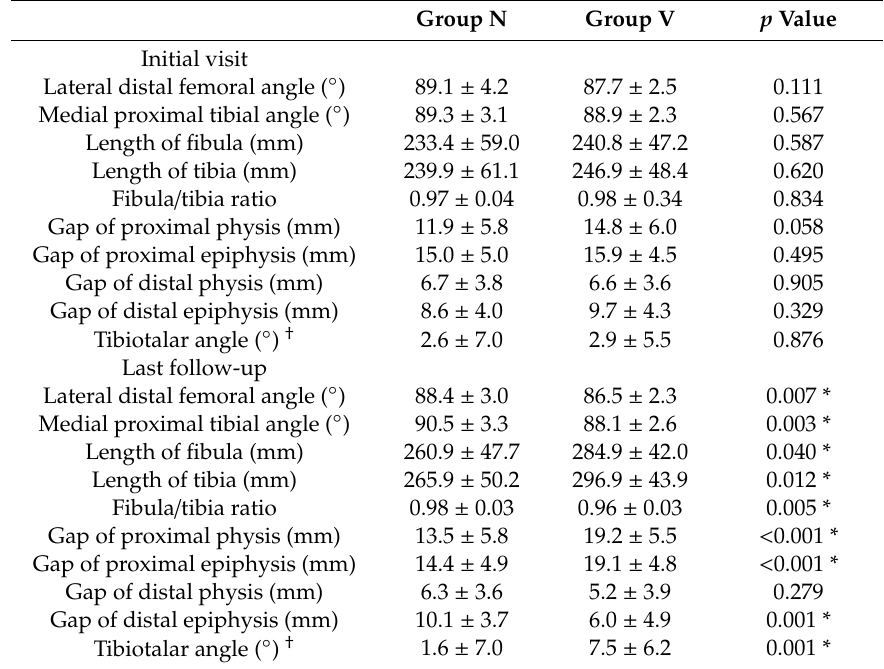
Table 2. Measurements of lower limb alignment at initial visit and last follow-up.